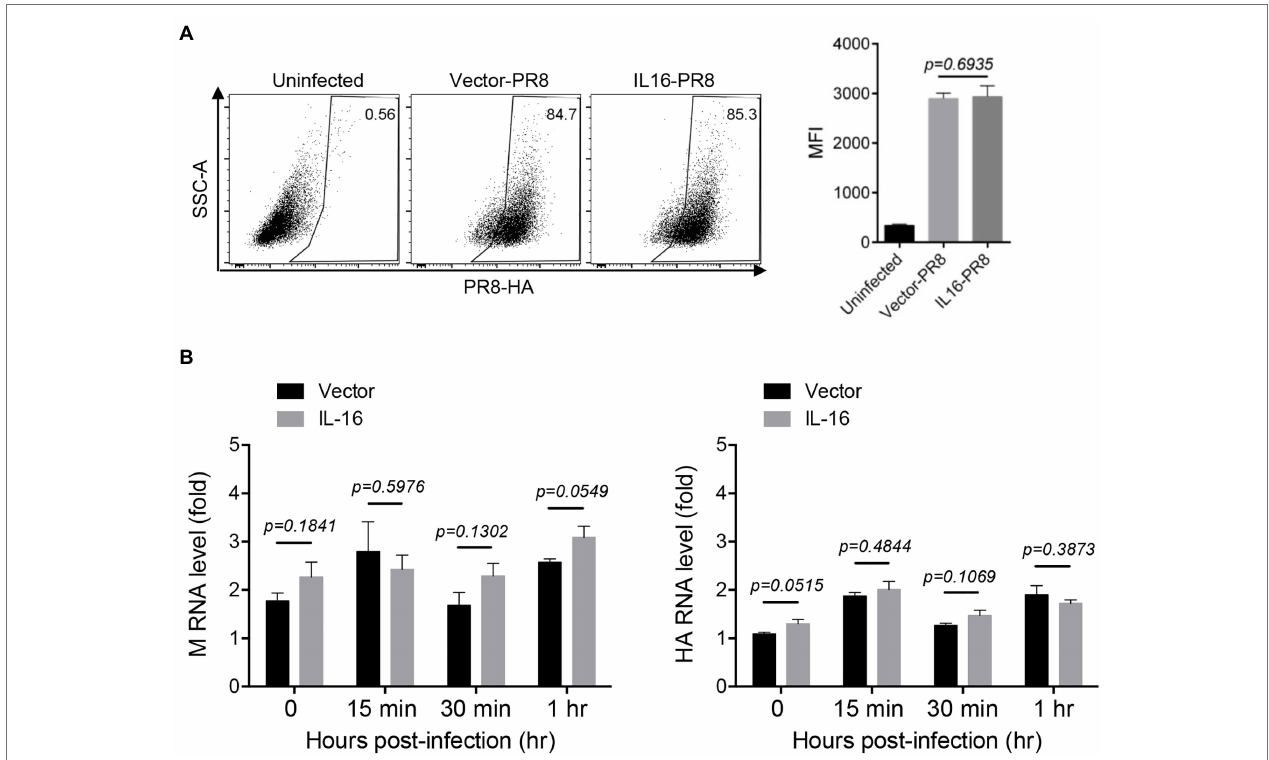
FIGURE 3 | IL16 overexpression does not affect IAV entry. (A) Madin–Darby canine kidney (MDCK) cells were transfected with vector or IL16-expressing plasmid for 24 h, followed by infection with PR8 virus (MOI = 10) at 4 ° C. The infected cells were surface-stained for HA and subjected to flow cytometry analyses. (B) A549 cells were transfected with vector or IL16-expressing plasmid for 24 h and were infected with PR8 virus (MOI = 1) at 4 ° C, followed by incubation at 37 ° C for 15 min, 30 min, and 1 h. The infected cells were harvested and subjected to qRT-PCR analyses with M and HA specific primers. Histograms represent mean ± SD of triplicate samples (two experiments). MFI represents mean fluorescent intensity. A value of p < 0.05 was considered